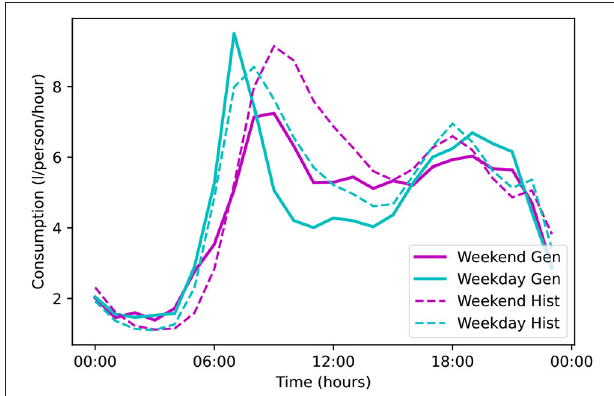
FIGURE 7 | The hourly per capita diurnal water consumption profile for the most populous metered area in the survey. (Solid lines) Average water consumption for a given hour from the generator on weekdays (cyan) and weekends (magenta). (Dashed lines) Average water consumption for a given hour from the metre survey on weekdays (cyan) and weekends (magenta).